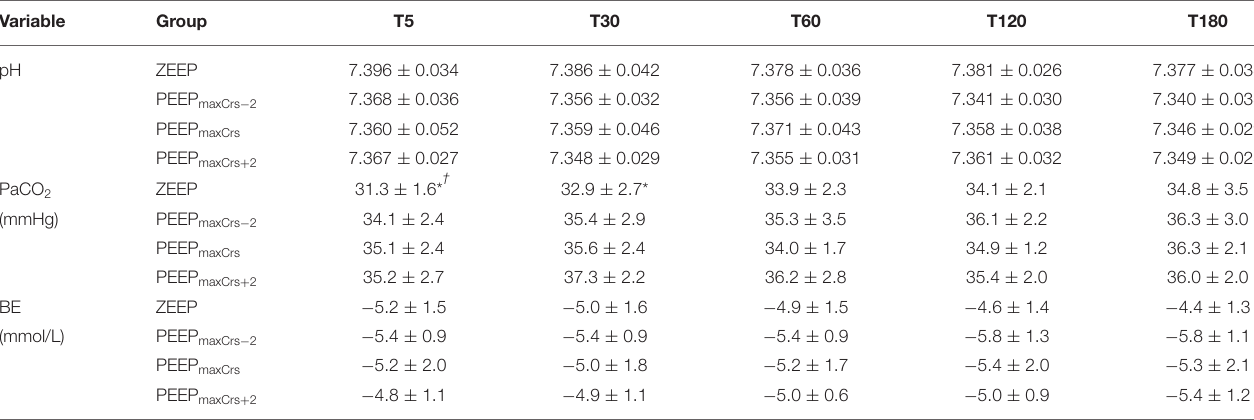
TABLE 5 | Acid-base variables in six (unless indicated within parenthesis) isoflurane-anesthetized cats mechanically ventilated for 3h with a tidal volume of 10 ml/kg and four end-expiratory pressure (EEP) treatments: zero end-expiratory pressure (ZEEP), positive end-expiratory pressure (PEEP) of highest respiratory system